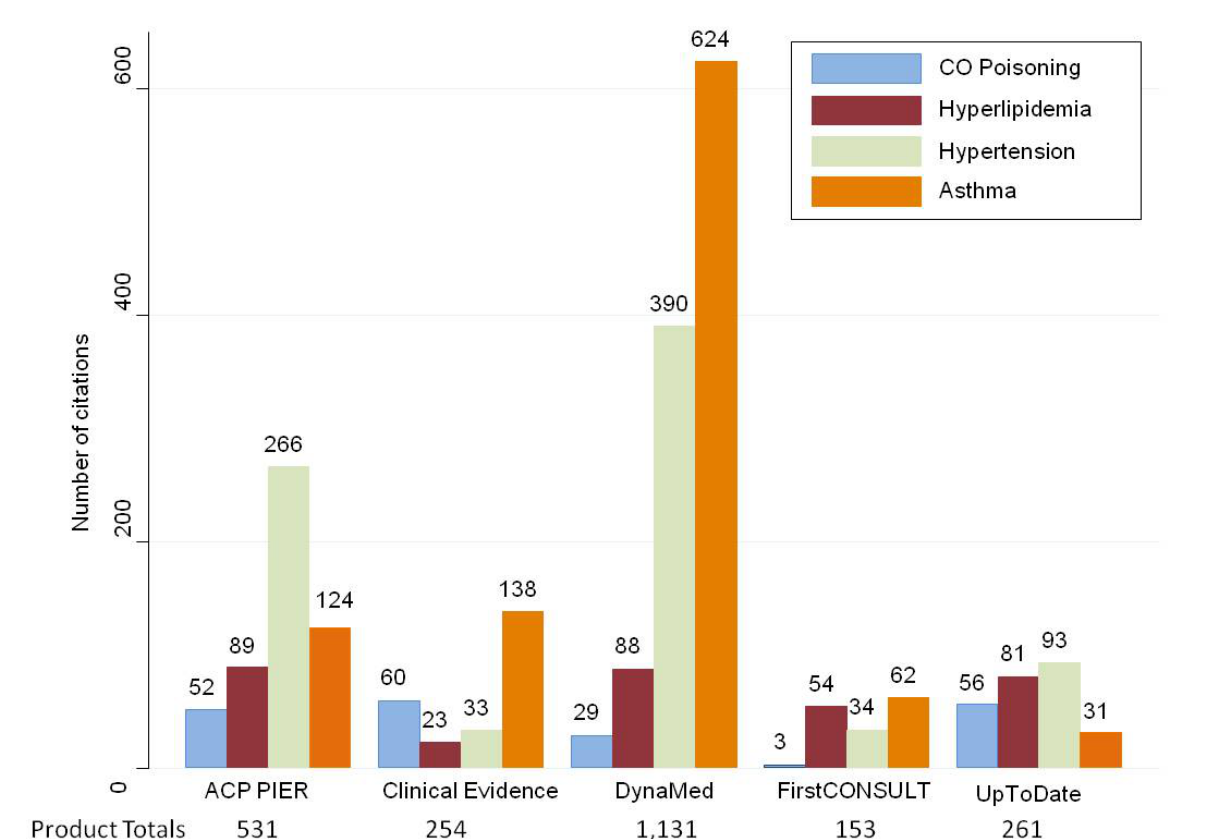
Figure 1. Number of citations for all topics within each point-of-care